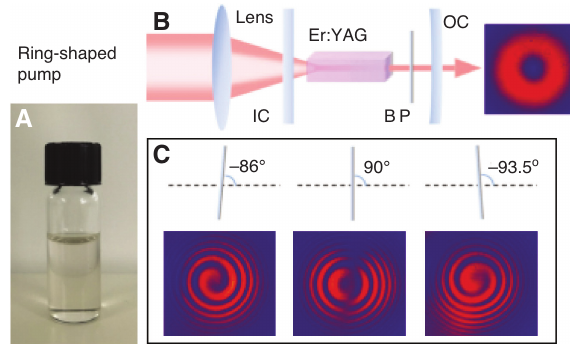
Figure 11: Vortex laser based on a black phosphorus plate [157]. (A) BP liquid sample. (B) Experimental setup used to excite the pulsed vortex laser and the intensity profile of the output. (C) The interference patterns with different tilt angles of BP [157].